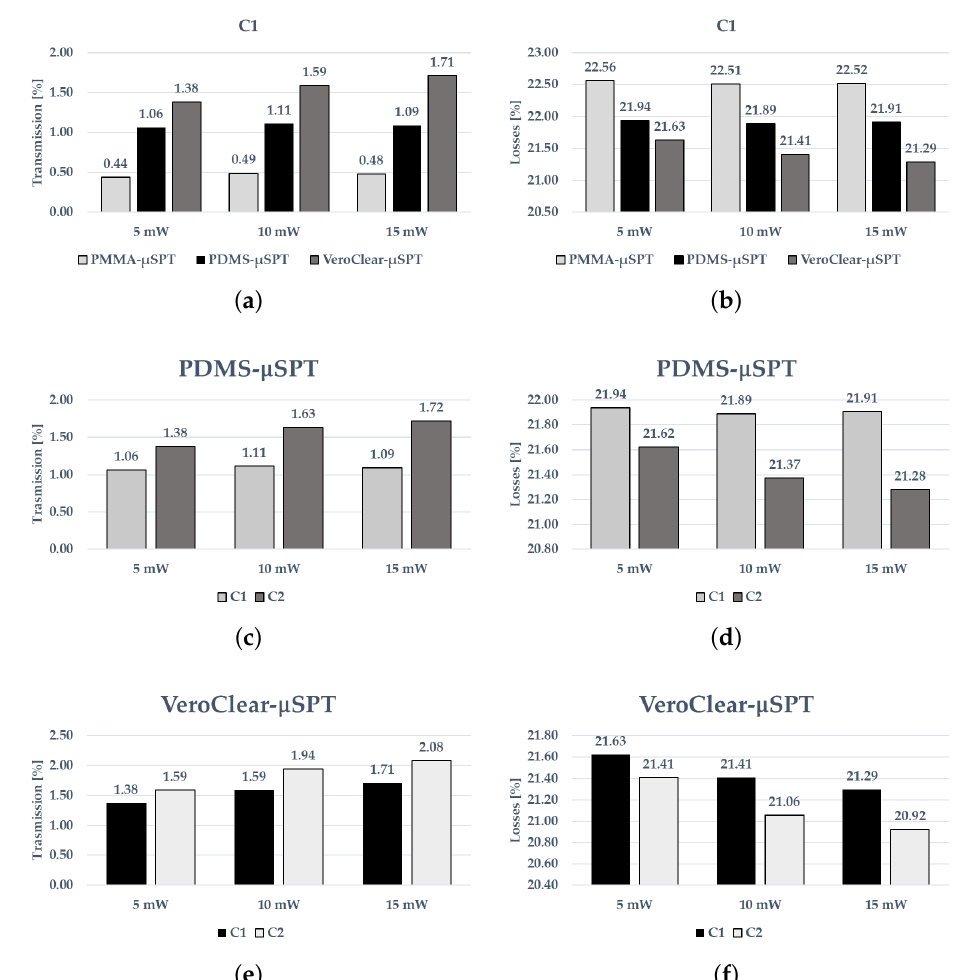
Figure 9. Histograms of ( a ) transmission and ( b ) losses for the the PMMA- µ SPT , the PDMS- µ SPT and the VeroClear- µ SPT in the configuration C 1. Comparison of the ( c ) transmission and ( d ) losses with the PDMS- µ SPT in the configurations { C 1, C 2 } . Comparison of the ( e ) transmission and ( f ) losses with the VeroClear- µ SPT in the configurations { C 1, C 2 } . The laser power at the input was varied at {5; 10; 15} mW. Bar errors were not added because they were strongly narrower than the bar